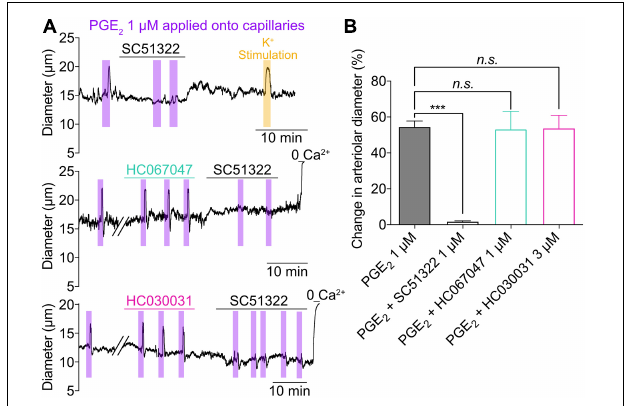
FIGURE 3 | Activation of capillary EP1 receptor initiates PGE 2 -induced upstream dilation independently of TRPV4 and TRPA1 channels. (A) Representative traces of arteriolar diameter showing effects of pressure ejection of PGE 2 1 µ M onto capillaries in absence or presence of SC51322 (1 µ M, EP1 antagonist), HC067047 (1 µ M, TRPV4 antagonist), and HC030031 (3 µ M, TRPA1 antagonist). (B) Summary data from 5 to 8